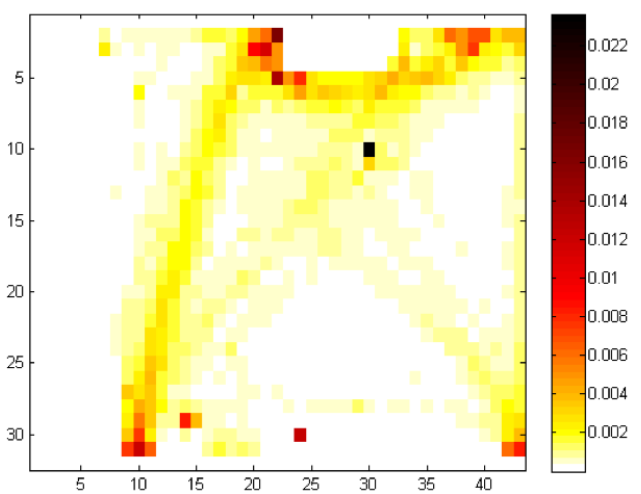
Figure 7. A normalized heat map for the 25th of August, as derived from trajectory data for that date. Scene-specific data can be used to calibrate the ABM, infusing it with knowledge about the particularities of the given scene. In order to assess the effects of various types of calibration data on the precision of the ABM we have chosen to explore four different scenarios, which build upon each other and are detailed